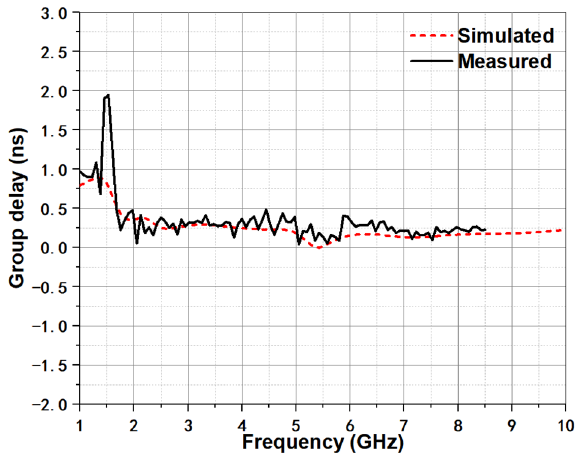
Figure 10. Simulated and measured group delay of compact UWB TSA.